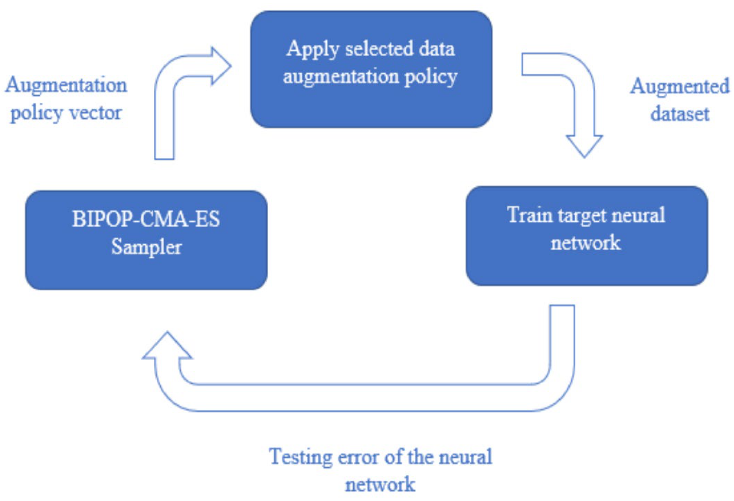
Figure 1. Workflow of the data augmentation optimization process.